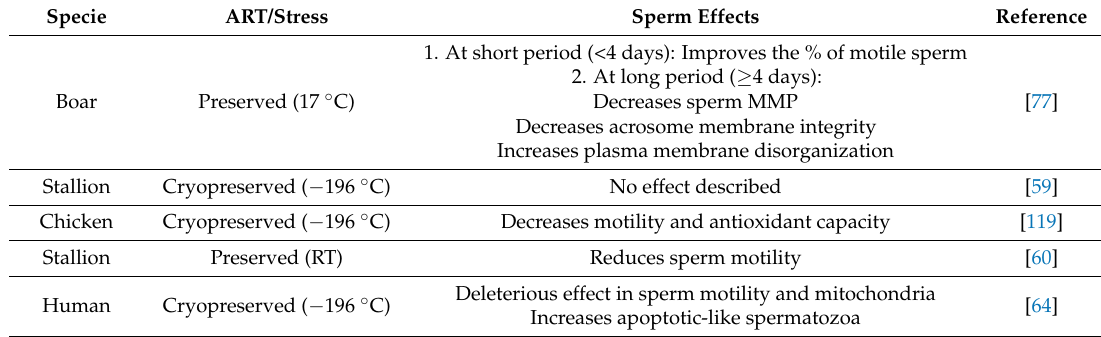
Table 1. Effects of the use of AMPK inhibitor C (compound C) in spermatozoa functions of several species during Assisted Reproduction Techniques